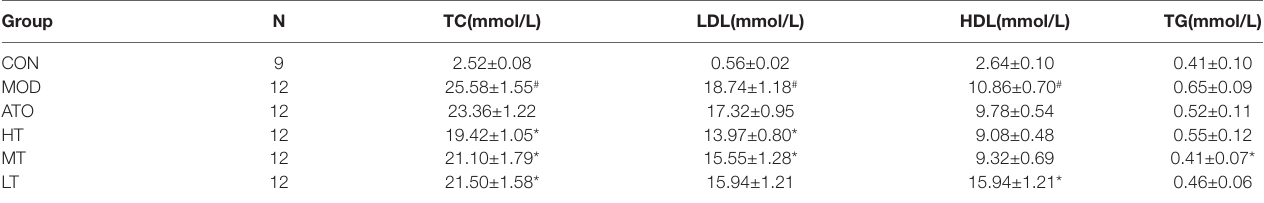
TABLE 1 | Blood lipid profile of each